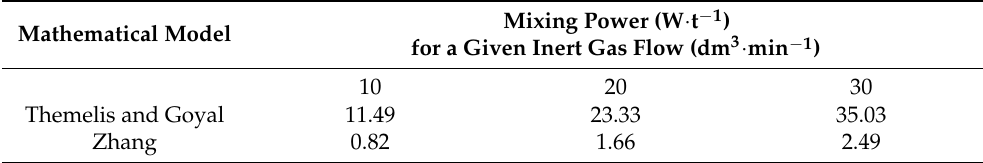
Table 5. Mixing power calculated from mathematical models.